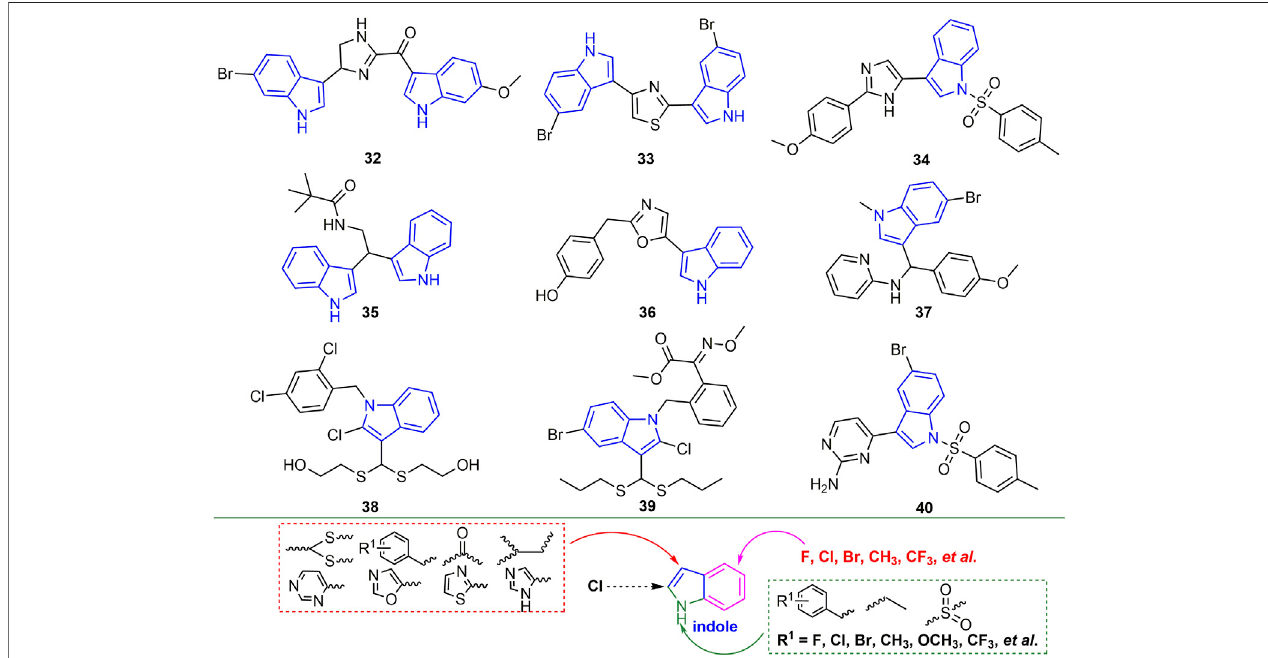
FIGURE 9 | Structures of representative indole derivatives in antiviral activities (I).